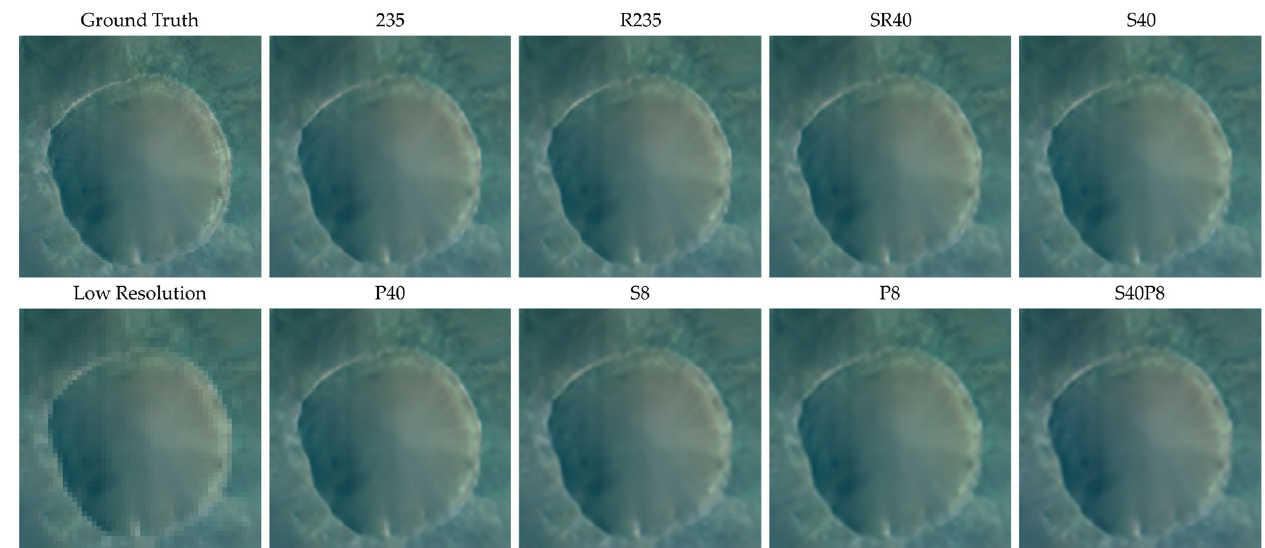
Figure 6. Comparison of the ground truth and the SR reconstruction images. The images in the first column are the original high-resolution (ground truth) and low-resolution images. The images in the other four columns are the SR reconstruction images reconstructed by the models trained on different datasets, and the name of the datasets are labeled in the titles of these images.